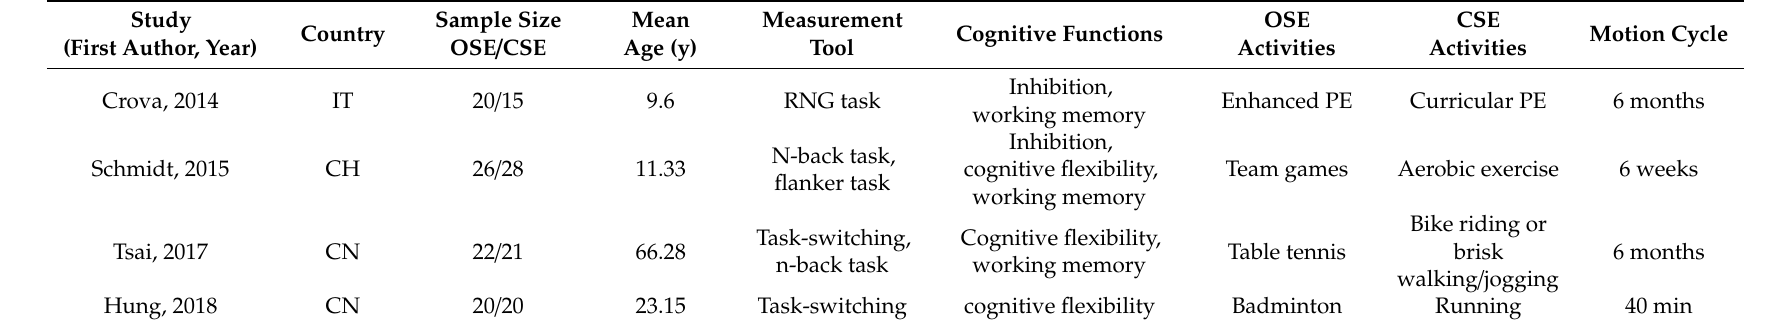
Table 2. Characteristics of the intervention studies